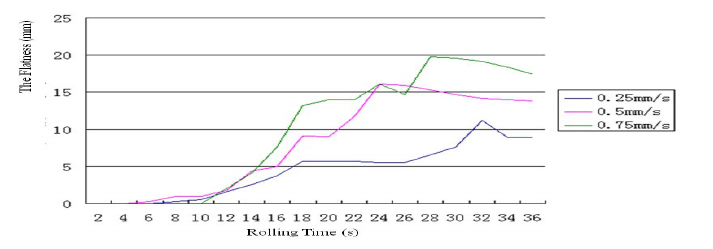
Fig. 10. The relation curves between the speed of the drive roller and the end face flatness